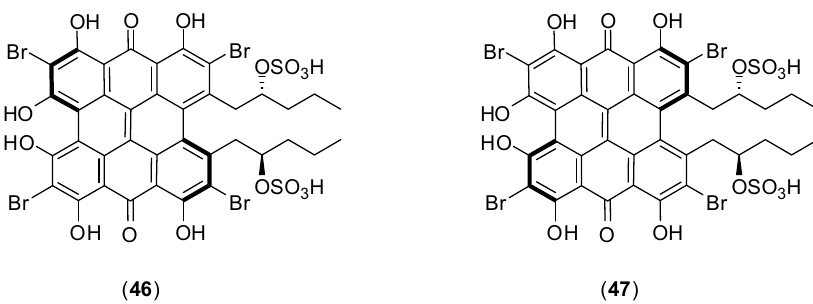
Figure 19. Structures of polycyclic quinones 46 and 47 .